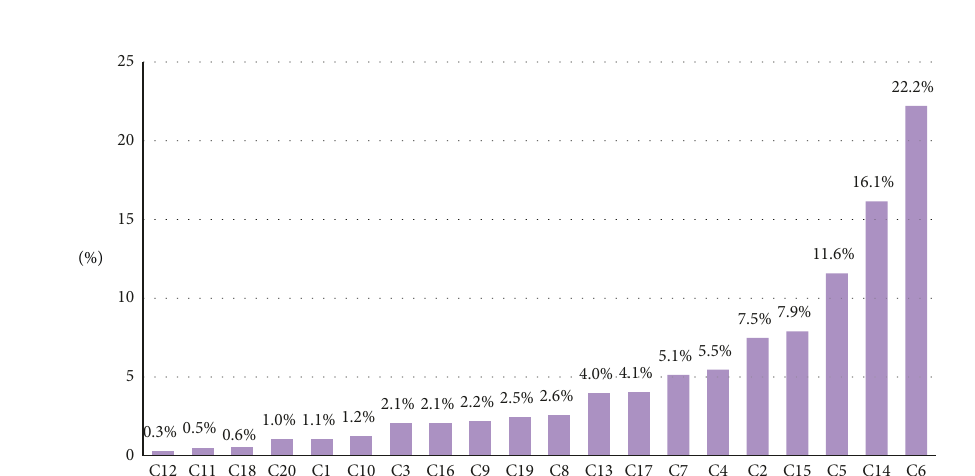
Figure 4: Total ranking of indicator weights of IEE performance